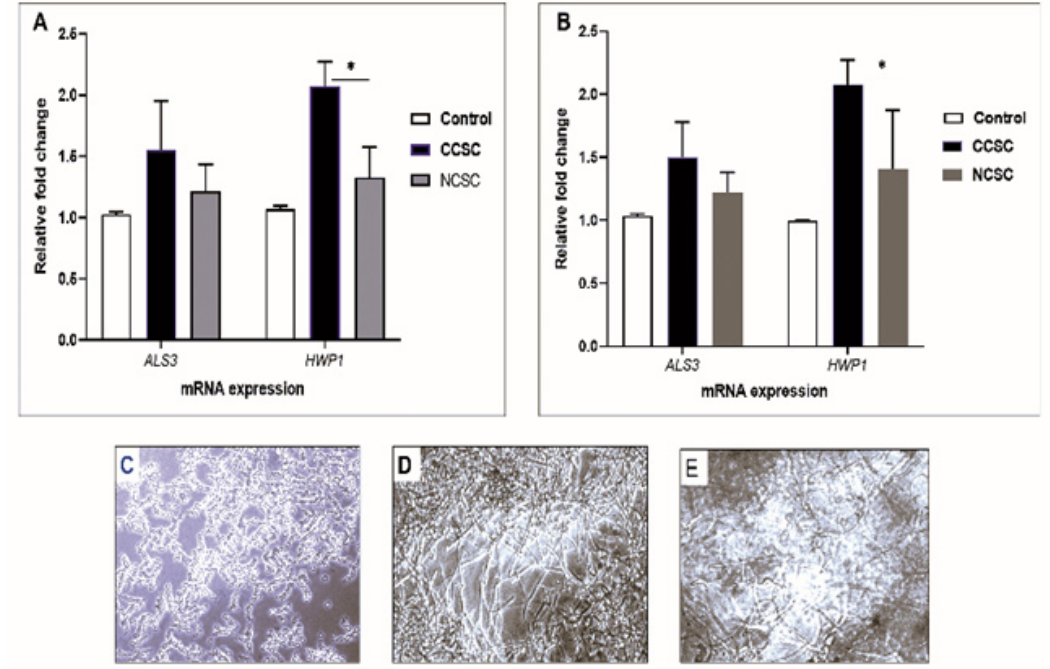
Figure 3. Effect of cigarette smoke condensate on the transcription level of selected C. albicans biofilm-associated genes. The qPCR analysis of ALS3 and HWP1 genes is shown after the preformed biofilm (90 min incubation) was treated by growth medium supplemented with different CSC (CCSC or NCSC). The mRNA level of each gene was normalized to that of 18S rRNA, while the expression level of the control (untreated biofilm) was set to one for each gene to determine the fold change in the expression of each targeted gene in clinical isolate ( A ) and the ATCC strain ( B ) of C. albicans . *Significantly higher upregulation of mRNA expression of HWP1 induced by CCSC than NCSC (P < 0.05). Data are expressed as the mean and standard deviation (SD) of triplicates from two separate experiments. The CCSC and NCSC are clove and non-clove cigarettes smoke condensate, respectively. The lower panel shows the 48-h biofilm formation that only shown in clinical isolate; the control ( C ) and those biofilms treated with CCSC ( D ) and NCSC ( E ), respectively. All the biofilms are visualized by using light microscopic images at X 200